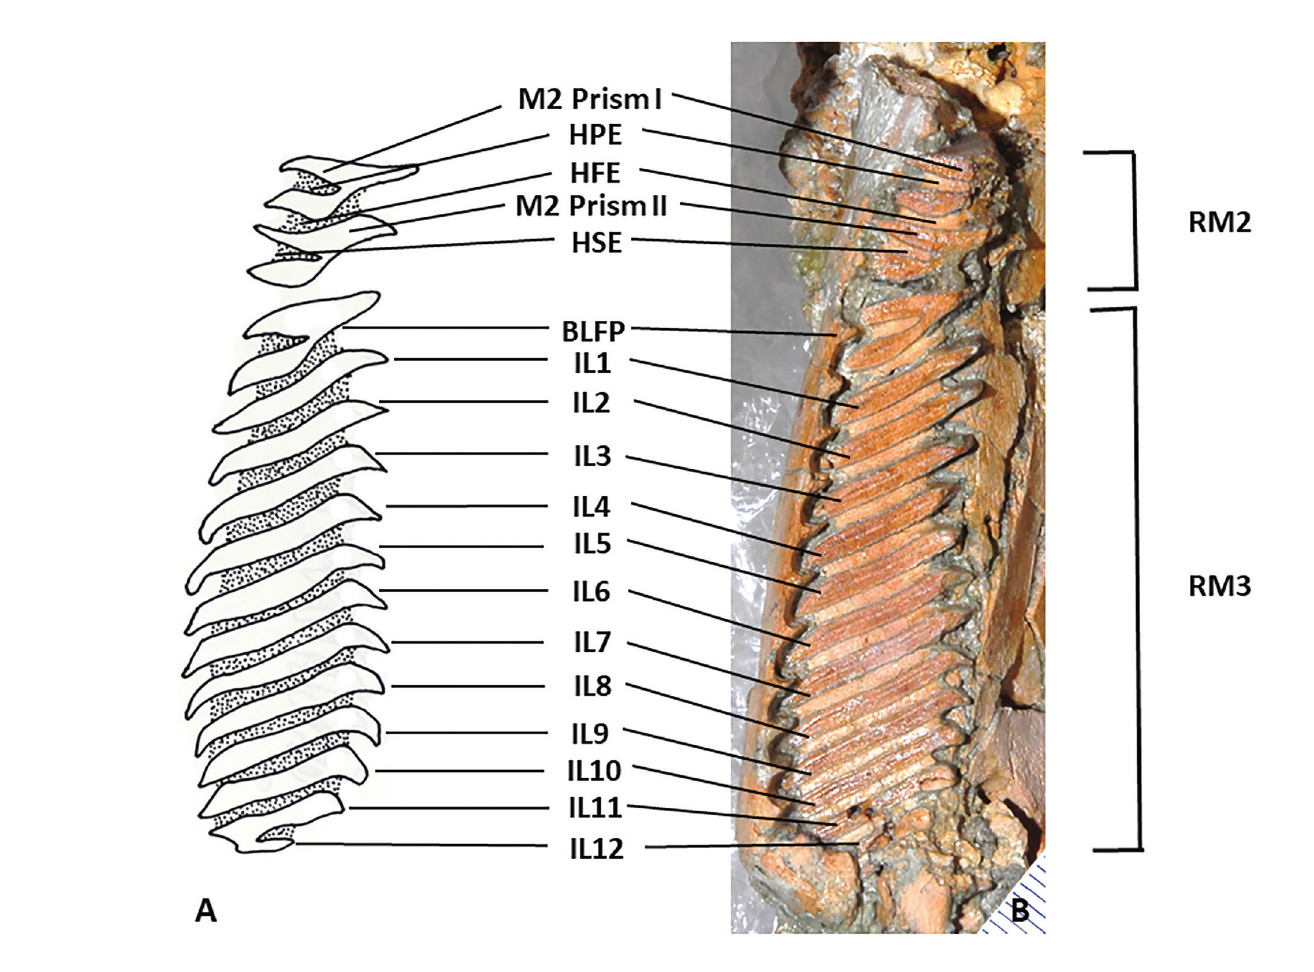
Figure 2. Dental terminology utilized in this paper. A, Hydrochoerus hydrochaeris after Mones (1991) : R M2 and M3 of SDSNH 50000. Abbreviations: RM2, second right upper molar; RM3, third right upper molar; HFE, Hendadura Fundamental Externa (Fundamental External Flexus); HPE, Hendadura Primeria Externa (Primary External Flexus); HSE, Hendadura Secundaria Externa (Secondary External Flexus); BLFP, BiLobed First Prism; IL1-12, Independent Prism